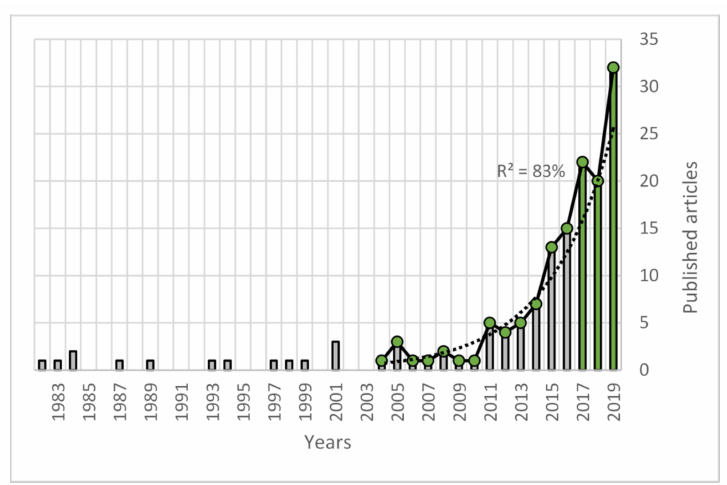
Figure 1. World scientific production